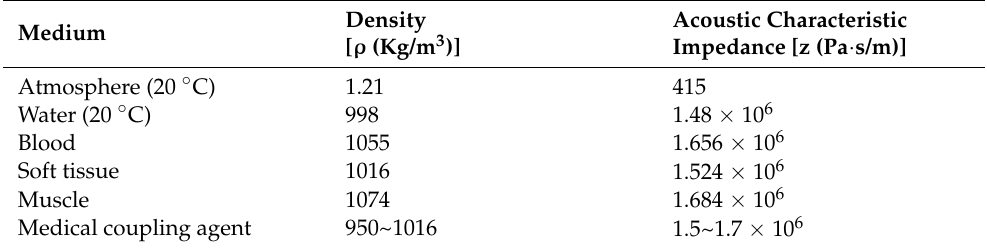
Figure 6. MEMS cardiac sound sensor acoustic encapsulate matching diagram. Table 3. Acoustic velocity values and characteristic acoustic impedances in varying media.